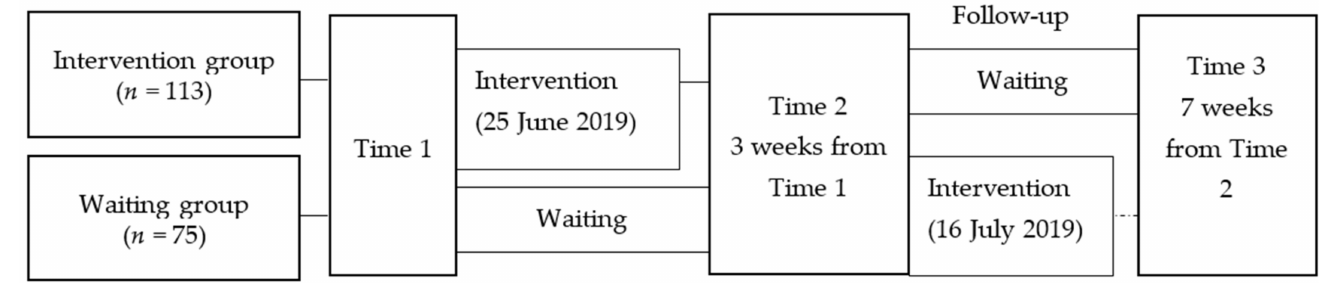
Figure 1. Flow of participants and